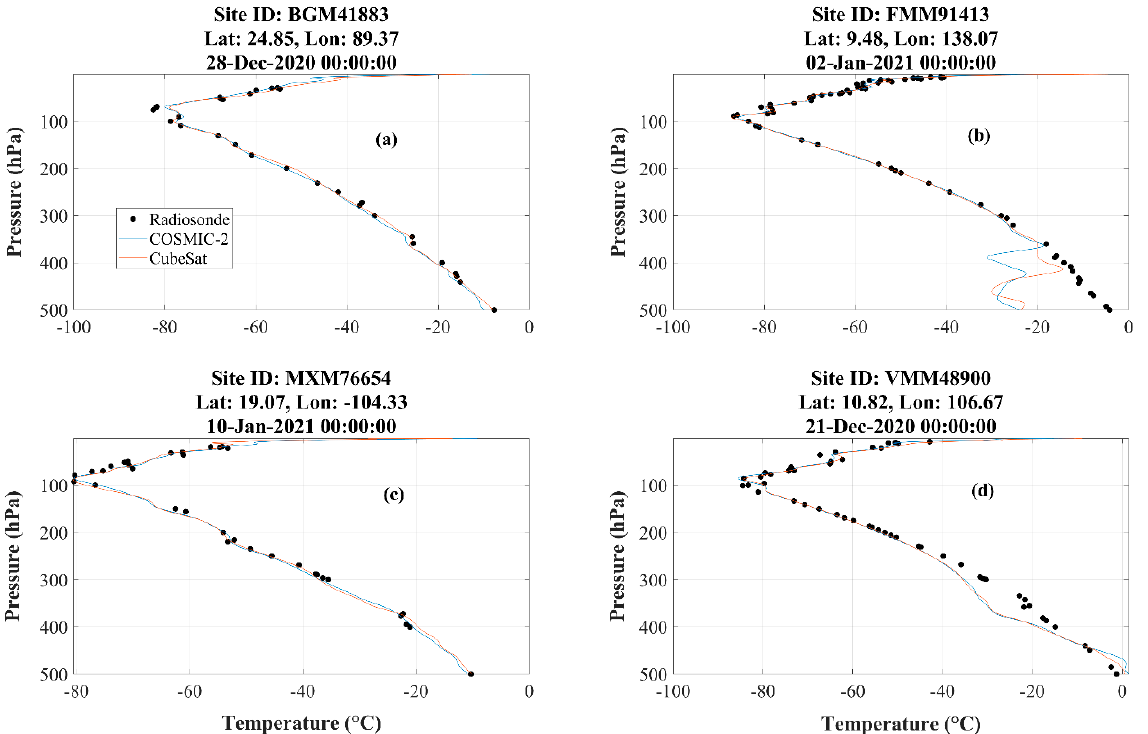
Remote Sens. 2022 , 14 , x FOR PEER REVIEW Figure 14. Comparing CubeSats and COSMIC-2 with the radiosonde observations as a reference in terms of the temperature and pressure. The profiles related to each site are provided in subfigures ( a – d ). Table 9. Mean and standard deviation (STD) of the differences between CubeSats and COSMIC-2 temperature values and the radiosonde observations for different pressures levels.